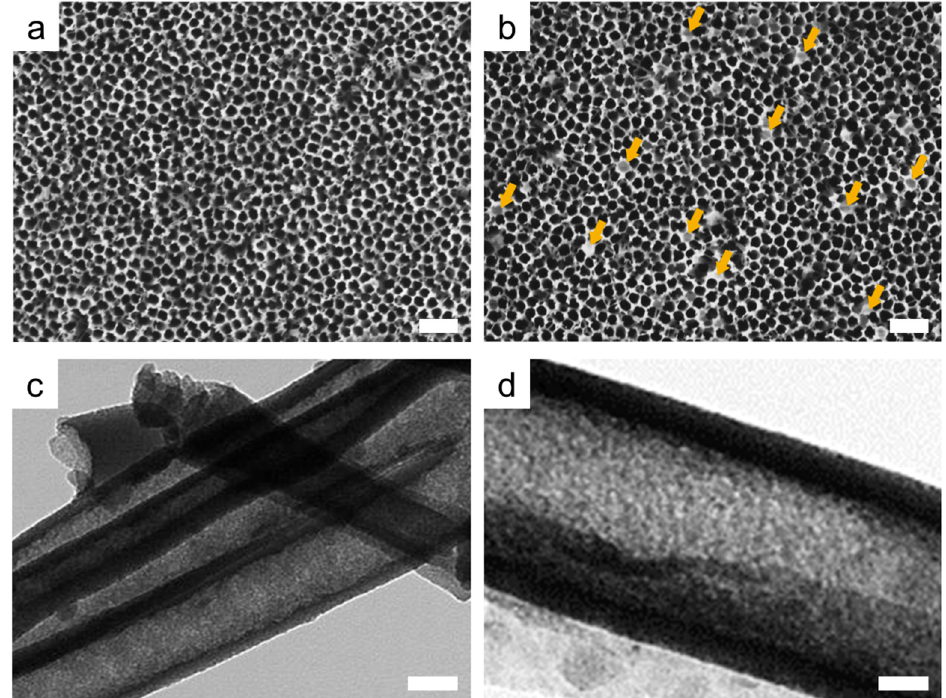
Figure 2. Morphological structure of pristine and sol-gel-coated anodized aluminum oxide (AAO) membranes. ( a ) Top-view scanning electron microscopy (SEM) images of pristine AAO membrane ( b ) and sol-gel-coated AAO membrane (scale bars denote 1 μ m). ( c , d ) Constructed sol-gel nanocolumn formed on the AAO nanochannel and observed by TEM after dissolving the AAO using a NaOH buffer. Scale bars denote 100 nm and 50 nm, respectively.